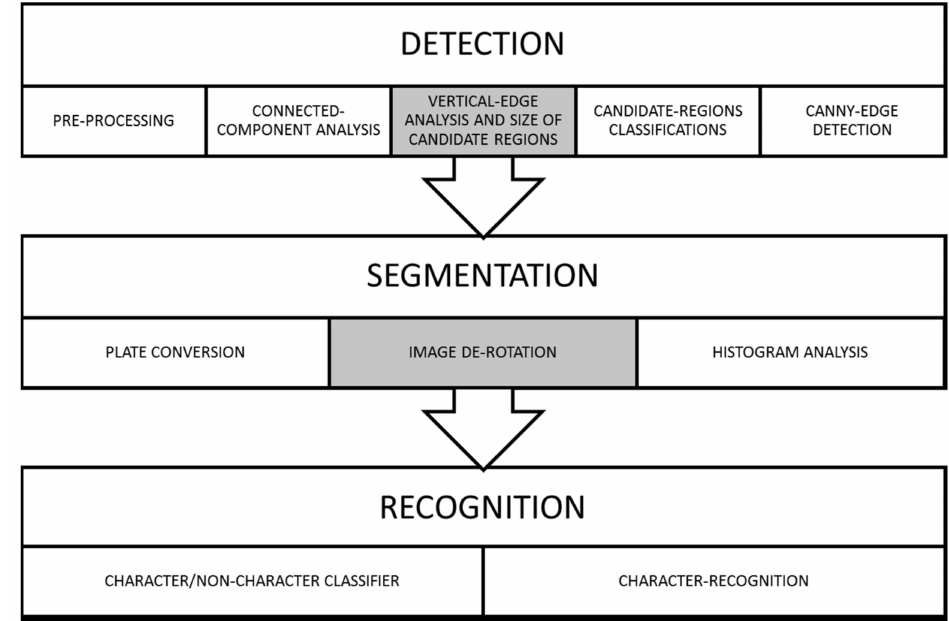
Figure 3. A block diagram of the proposed ALPR system with the suggested enhancements highlighted.